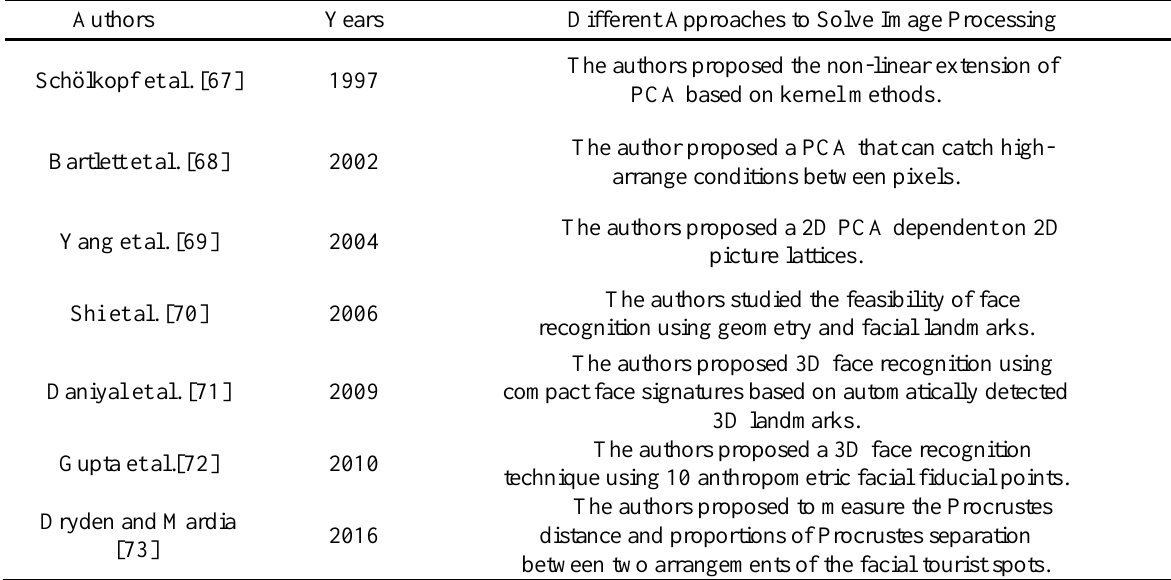
Table 1. A literature review of Geometry and holistic based image processing.